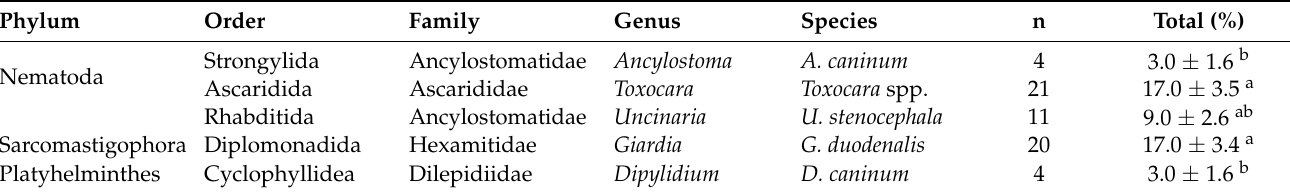
Table 1. Prevalence of playground zoonotic